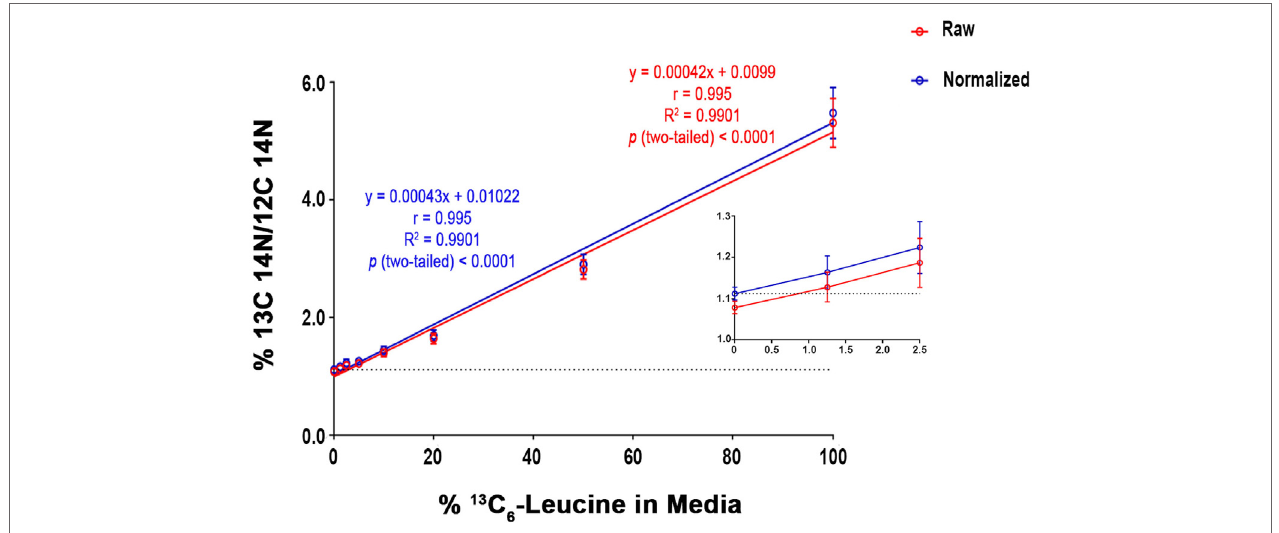
FigUre 1 | SILK-SIMS dose response curve for 13 C 6 -leucine enrichment. B-cell hybridoma cells were labeled with increasing percentages of 13 C 6 -leucine. The standard curve demonstrates a monotonic relationship between detected 13 C 14 N/ 12 C 14 N and the percent 13 C 6 -leucine enrichment in cell media. Red line represents the mean of 13 C 14 N/ 12 C 14 N ± SD of the regions-of-interest outlined in (Figure S3 in Supplementary Material). The blue line represents the normalized mean 13 C 14 N/ 12 C 14 N ± SD. Each standard curve point was normalized (Equation 4 in Supplementary Material) to the ratio of natural abundance 13 C and unlabeled cells (0%). The normalized SD was calculated as the sum in quadrature of the SD of the average ratios measured for non-labeled cells (0%) and the Poisson errors of the feature itself (Equation 5 in Supplementary Material). Note the expected intercept at ~1.1%. Inset: enlarged view of the three lowest points on the dose-response curve. Enrichments as low as 1.25% were detectible above background. Dashed horizontal line represents natural abundance of 13 C